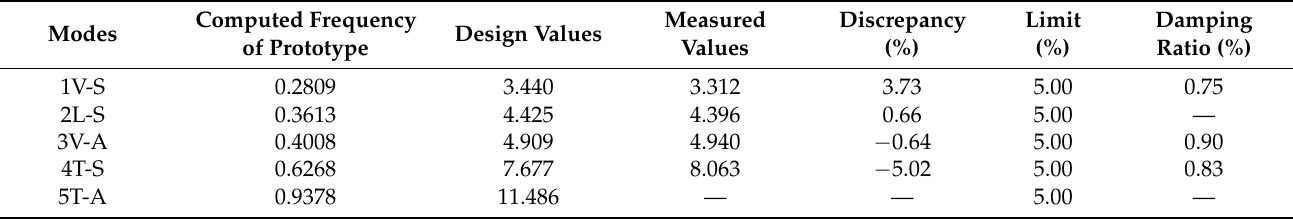
Table 6. Scaling parameters for Froude number similitude.